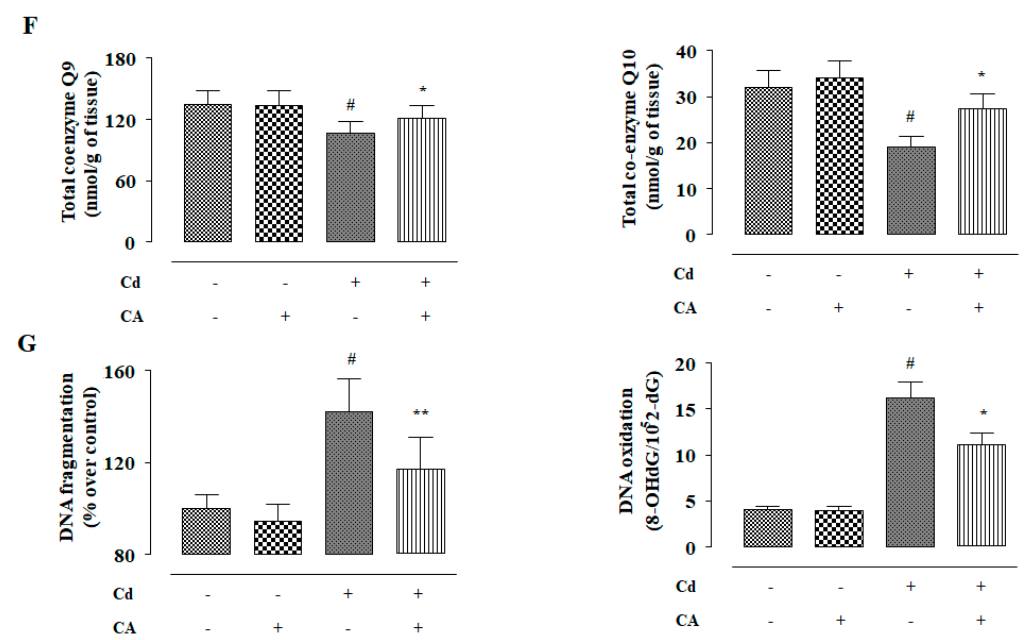
Figure 5. The effects of CdCl 2 and/or CA on the redox imbalance in vivo in mouse kidney. ( A ) Scheme for in vivo experiment. ( B ) The effect on ROS accumulation, NO production, H 2 O 2 level, and NADPH oxidase activity. ( C ) The effects on lipid peroxidation and protein carbonylation. ( D ) The effects on GSH level and redox ratio. ( E ) The effects on endogenous antioxidant molecules. ( F ) The effect on total co-enzymes Qs. ( G ) The effects on DNA oxidation and DNA fragmentation. Data are represented as the mean ± SD, n = 6. # Values significantly ( p < 0.01) differed from the vehicle-treated group. * Values significantly ( p < 0.05) differed from only the CdCl 2 -treated group. ** Values significantly ( p < 0.01) differed from only the CdCl 2 -treated group. SOD unit, “U”, is defined as inhibition (µ-moles) of NBT-reduction/min. CAT unit, “U”, is defined as H 2 O 2 consumption/min.